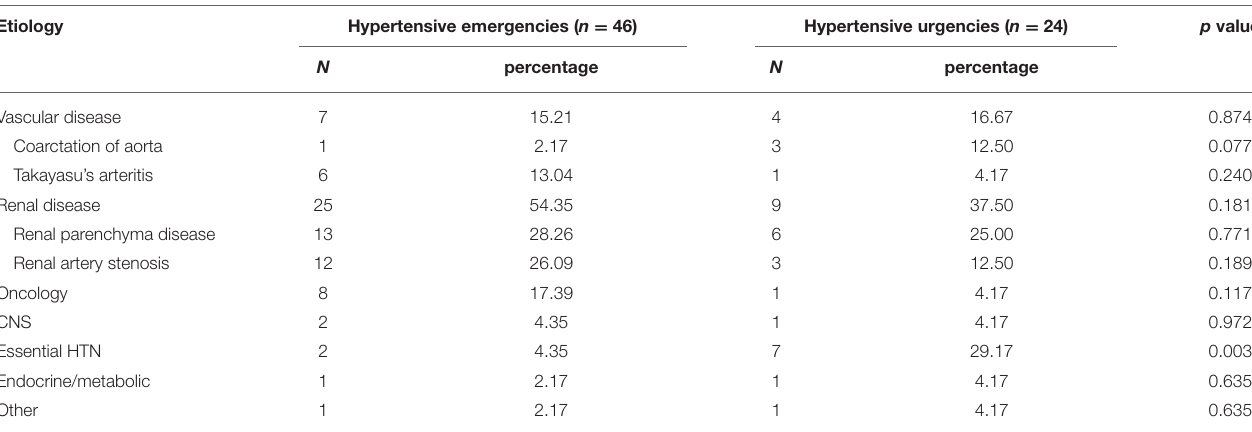
TABLE 2 | Etiology of the patients with hypertensive